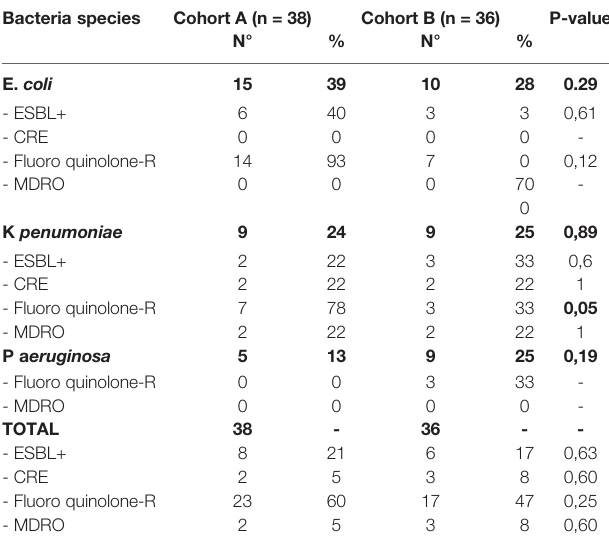
TABLE 4 | Antibiotic resistance of E. coli , K pneumoniae , and P aeruginosa isolated in all the BSIs. Bacteria